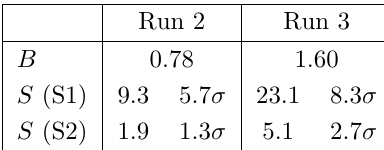
Table 2 . Expected number of signal ( S ) and background ( B ) events, and statistical signi(cid:12)cance ( n (cid:27) ) of the signal, for LHC Runs 2 and 3. The Z 0 coupling is set as g Z 0 Y 0